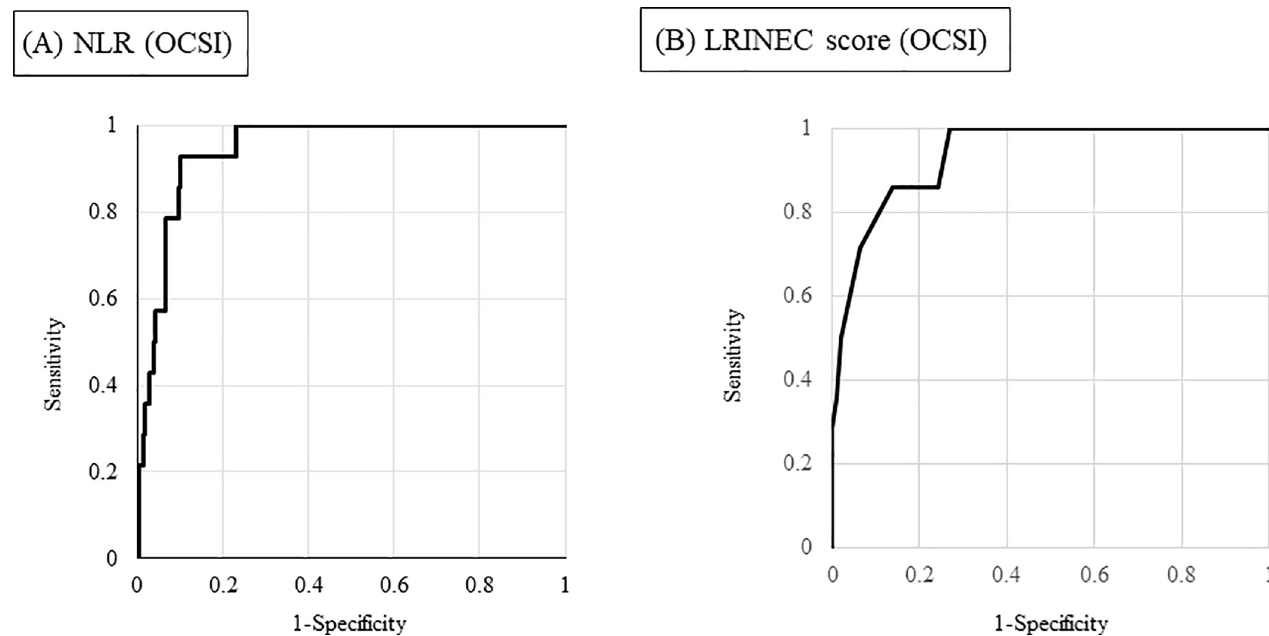
Fig 1. (A) The ROC curve for accuracy of NLR in predicting the presence of OCNF in OCSI patients. The AUC for our model was 0.944 (95% confidence interval 0.907 to 0.982). (B) The ROC curve for accuracy of LRINEC score in predicting the presence of OCNF in OCSI patients. The AUC for our model was 0.938 (95% confidence interval 0.889 to 0.987).